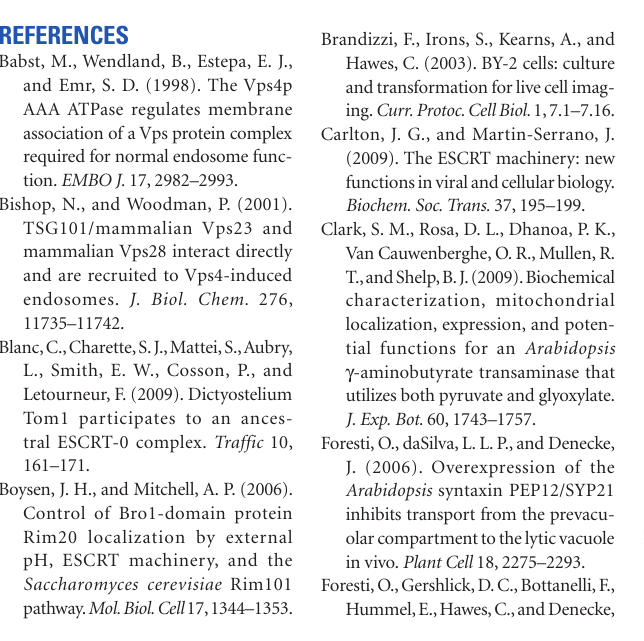
protein, or (B) α ‑HA antibodies, which recognize the HA epitope tag located between the GAL4‑BD moiety and ESCRT protein. All of the immunodetected AD/BD‑ESCRT fusion proteins (indicated with upward or downward arrows) were consistent with their expected (ca.) sizes; although, in some cases, smaller, additional bands were also observed, likely truncated version of these proteins due to internal translation initiation and/or partial protein degradation. Note also in (A) a non‑specific, ∼ 80 kDa endogenous yeast polypeptide (marked with an asterisk) was immunodetected in protein blots probed with α ‑Myc antibodies. Numerical values to the left of blots are the molecular masses (in kDa) of protein standards. FIGuRE S2 | Representative two-hybrid-assay plates showing the relative growth of selected AD- and BD- Arabidopsis ESCRT co-transformed yeast strains. Yeast harboring (co‑transformed) either individual pairs of each of the positive two‑hybrid‑interacting AD‑ and BD‑ESCRT fusion proteins (refer to shaded boxes in Figure 2) or the corresponding “empty” AD or BD control plasmids (refer to the top two rows in Figure 2), were (replica) spotted onto agar plates containing either (B) low‑stringency selection media (SD‑LT), (C) high‑stringency selection media (SD‑LTHA) without 3‑AT, or (D) SD‑LTHA with 3‑AT, and incubated for 5 days at 30 ° C. Shown in (A) are the locations (drawn as circles) on the plates of each of the co‑transformed yeast strains examined, as well as the specific combinations of AD‑ and BD‑ESCRT (or “empty vector”) plasmids they harbor (numbered 1–150). FIGuRE S3 | Co-immunoprecipitations of Arabidopsis ESCRT proteins in vitro . Plasmids encoding selected AD‑ or BD‑ESCRT fusion proteins (which included an HA or Myc‑epitope tag between the GAL4‑AD or BD moieties, respectively, and the ESCRT protein) were transcribed and translated in vitro (see Materials and Methods for details). Translation products for specific protein pairs (referred to as “prey” and “bait”) or only the “prey” proteins serving as negative controls were mixed and incubated [as indicated below each blot (IP)] with either α ‑Myc or α ‑HA antibodies, followed by an incubation with Protein A‑Sepharose and then centrifugation. Next, equivalent amounts of all co‑immunoprecipitated protein fractions, as well an aliquot of in vitro ‑synthesized “prey” protein alone (refer to the first lane in each blot) were subjected to SDS‑PAGE and Western blotting with (as indicated to the left of each blot) either α ‑HA or α ‑Myc antibodies and the appropriate enzyme‑linked secondary antibodies. Arrowheads at the right side of the blots indicate the migration positions of the specific immunodetected “prey” proteins. The additional lower molecular mass proteins observed in most blots are IgGs carried over from the co‑immunoprecipitation reactions. Shown also (on the right) are compilations of blots of the individual HA‑ or Myc‑tagged “bait” proteins used as input for corresponding co‑immunoprecipitations reactions. FIGuRE S4 | Subcellular localization of Vps28A. Movie depicting the CLSM 3D projection (full z‑series) of immunostained Myc‑Vps28A in the Myc‑Vps28A and HA‑Vps23A co‑transformed cell shown in Figure 4B (bottom row).